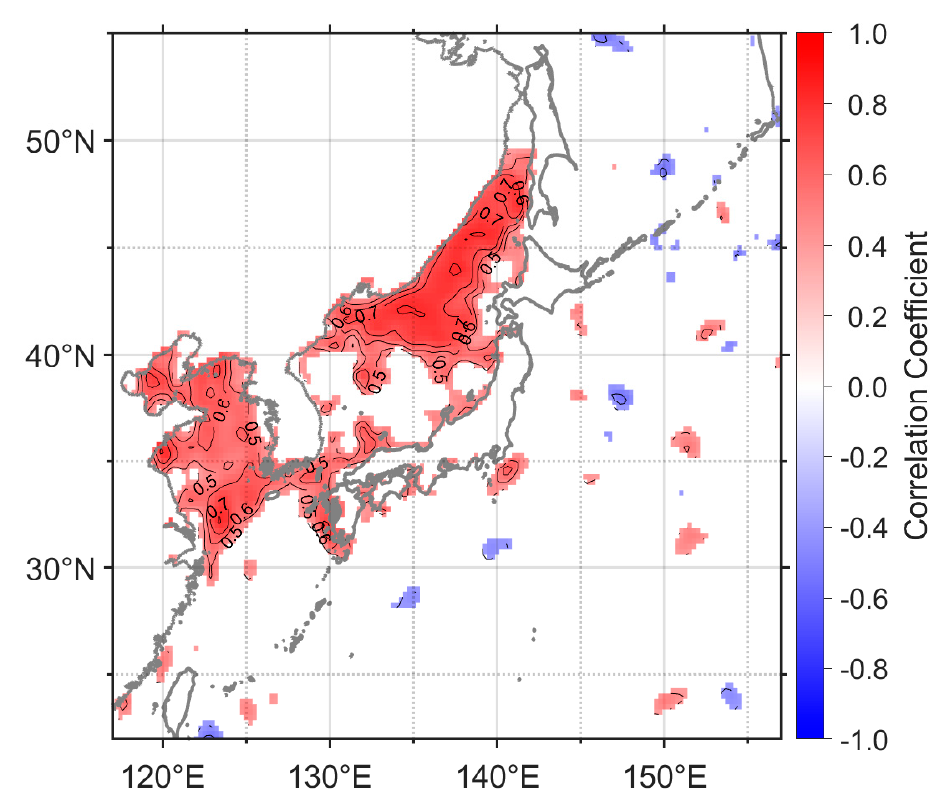
Figure 12. Correlation map of the August sea-level with the ANSI from 1993 to 2018. The contour interval is 0.1 and confidence levels less than 95% were eliminated. A positive correlation indicates that high sea-level occurs with the positive ANSI.